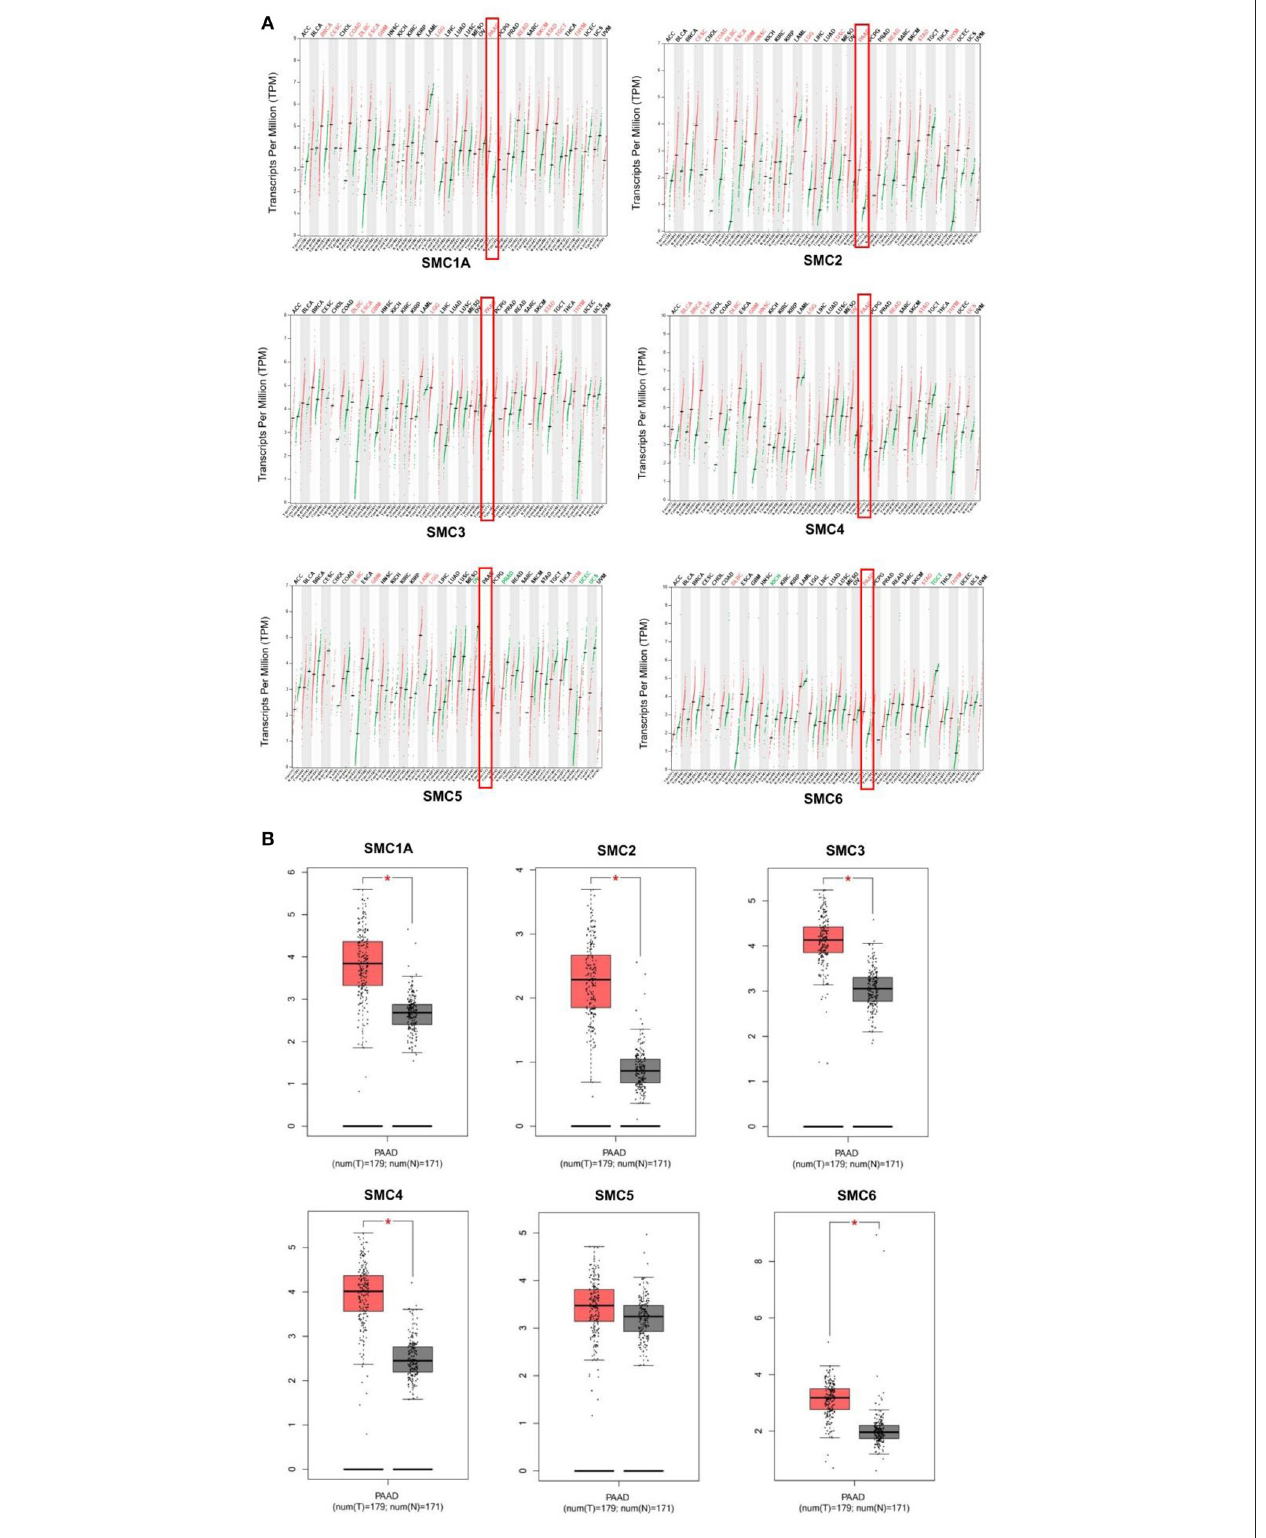
FIGURE 1 | Differential expression of structural maintenance of chromosomes (SMC) family members. (A) The mRNA expression levels of SMC gene family members in different cancer types, as analyzed using the TIMER database. (B) The mRNA expression of SMC gene family members in pancreatic adenocarcinoma (PAAD), as obtained from the GEPIA database. * P <